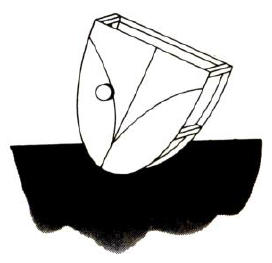
Figure 1. Centre of gravity.